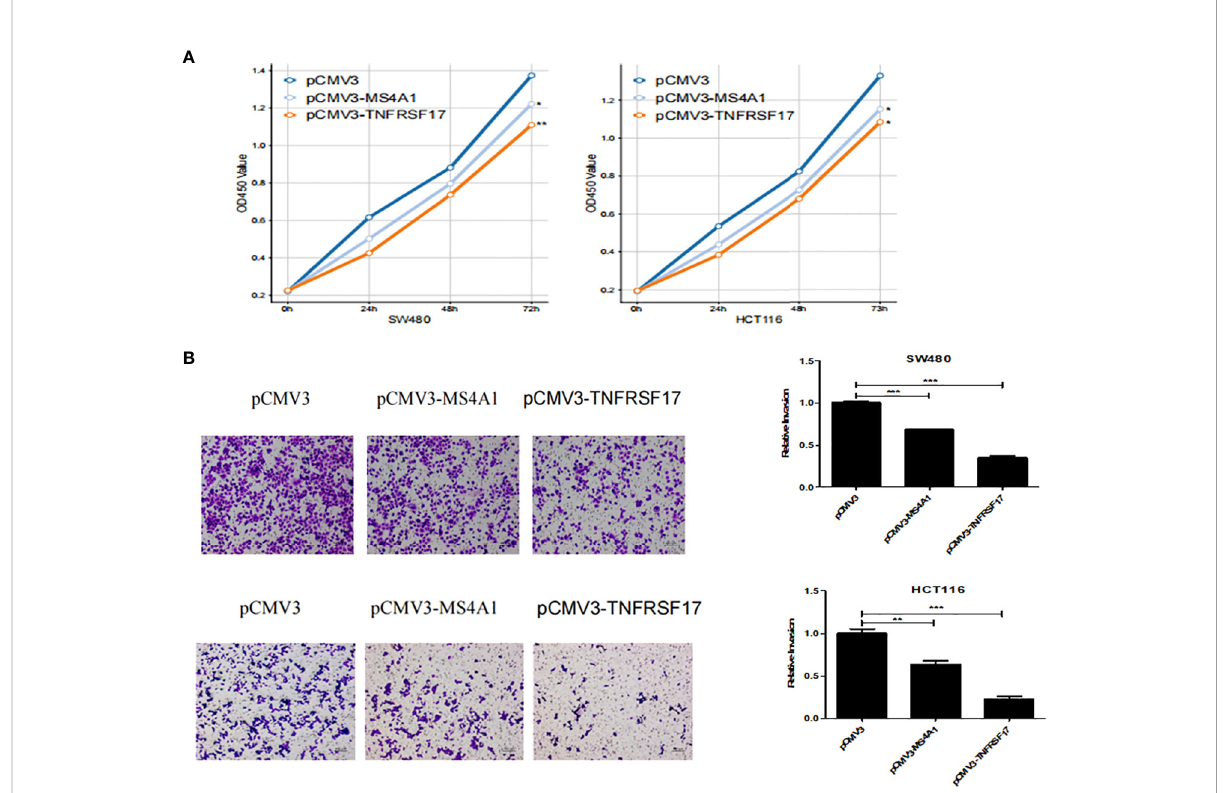
FIGURE 8 CCK8 and Transwell experiments. (A) The proliferation ability of SW480 cells and HCT116 cells transfected with pCMV3-MS4A1 and pCMV3- TNFRSF17 was signi fi cantly reduced. (B) The invasive ability of SW480 cells and HCT116 cellstransfected with pCMV3-MS4A1 and pCMV3- TNFRSF17 was signi fi cantly reduced. *,<0.05; **,<0.01;